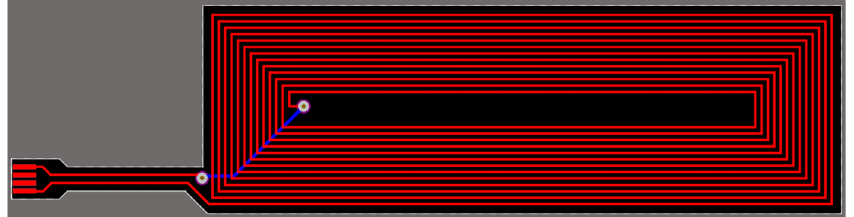
Figure 3. Flexible PCB track design for the antenna resonant to 13.56 MHz when combined with the ST25DV NFC chip (L = 4.88 µH).